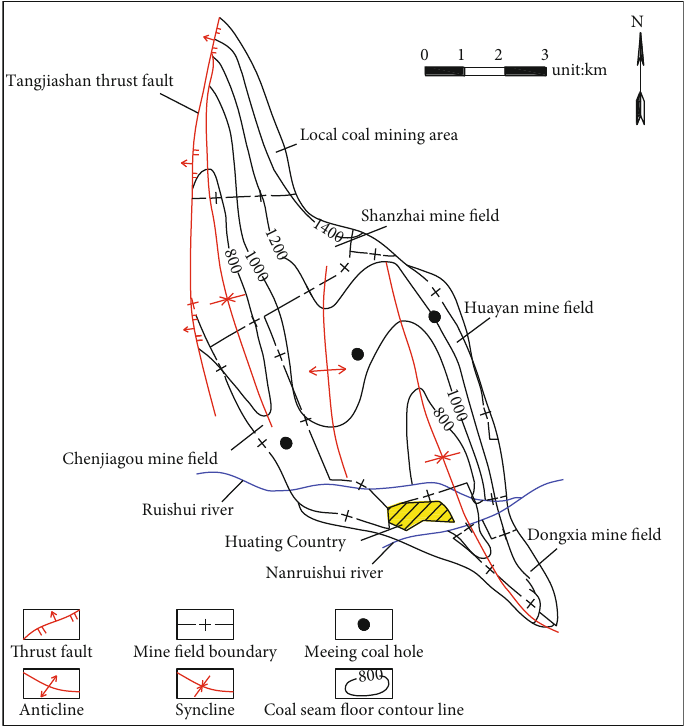
Figure 1: Geological structure plan of Huayan mine fi eld.